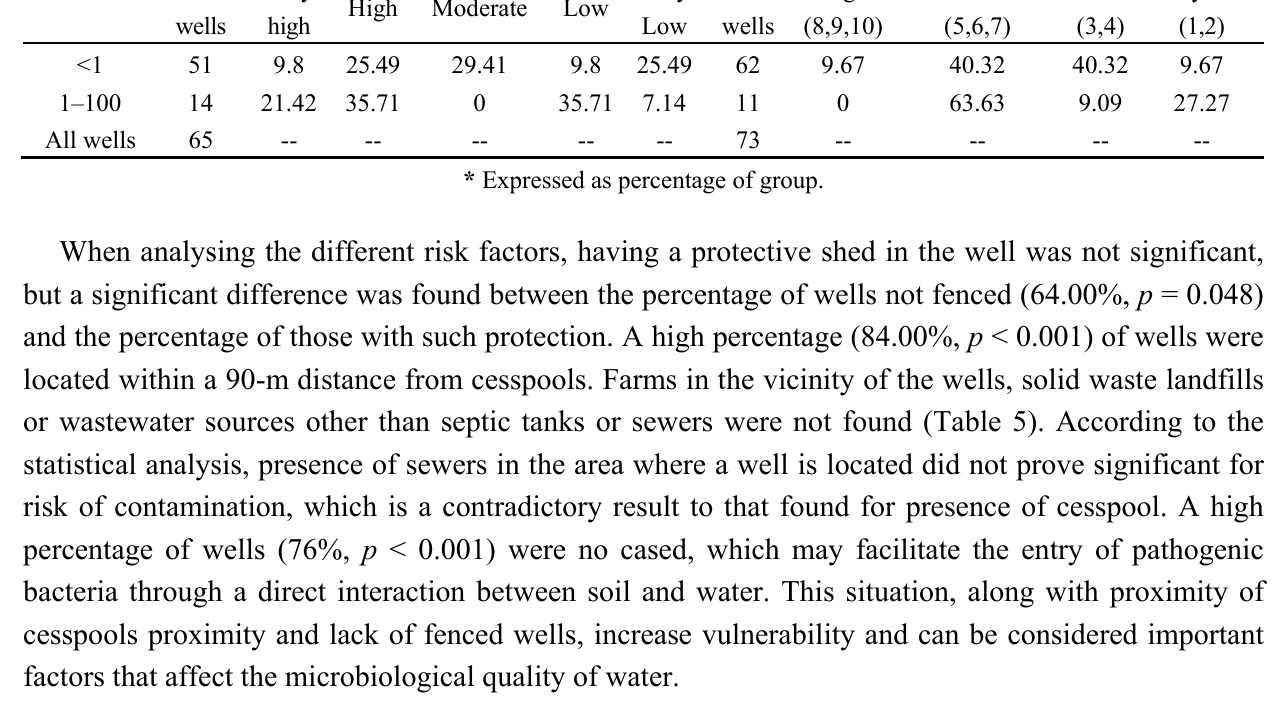
Table 5. Risk factors for wells with high frequency of microbiological